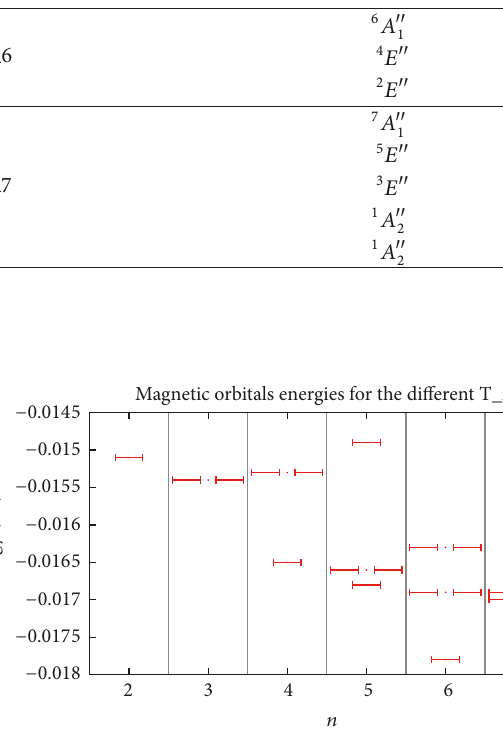
Figure 23: Ab initio magnetic orbitals spectra for T 2 to T 7.